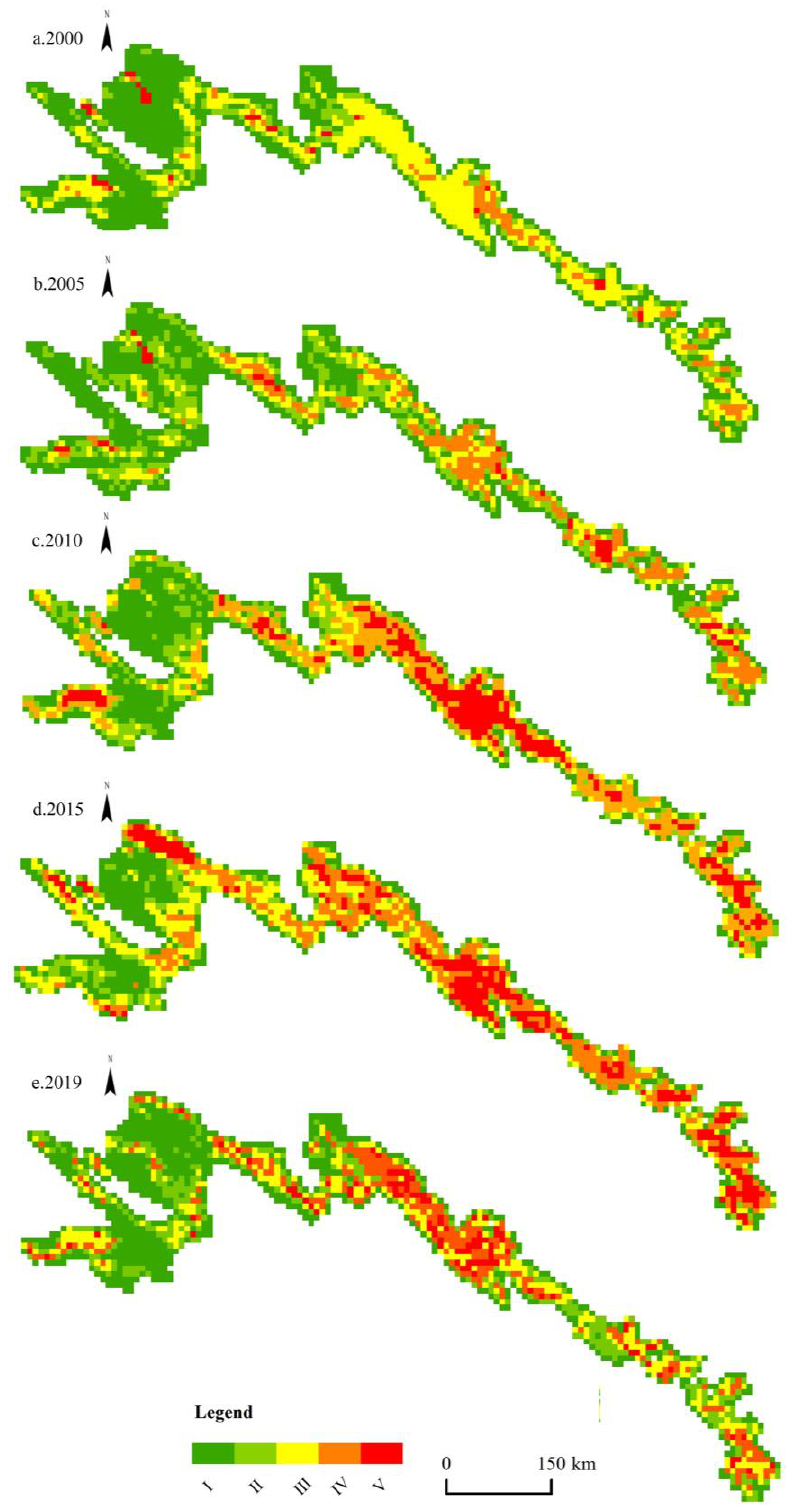
Figure 4. Value characteristics of land ecosystem services in Qilian Mountain National Park (Gansu area), 2000–2019. ( a – e ) represent the value characteristics of land ecosystem services in 2000, 2005, 2010, 2015, and 2019, respectively. I–V mainly represent the intensity ranking of the total value of ecosystem services from low to high, classified according to the five-level natural fracture method in ArcGIS software.